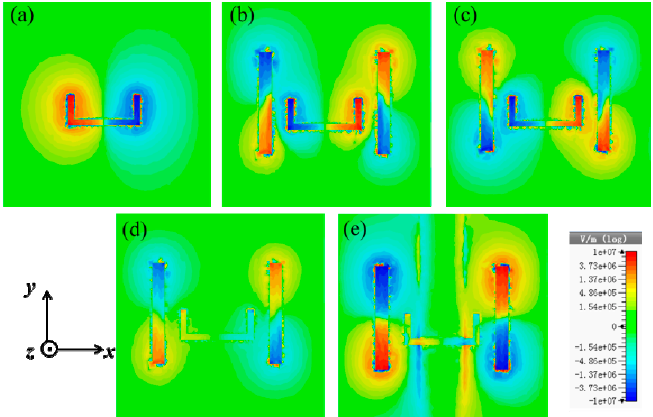
Figure 2. Transmission spectra of the sole U-shaped ring, the sole cut-wire pair, the combined structure, and the hybrid structure with a graphene layer.